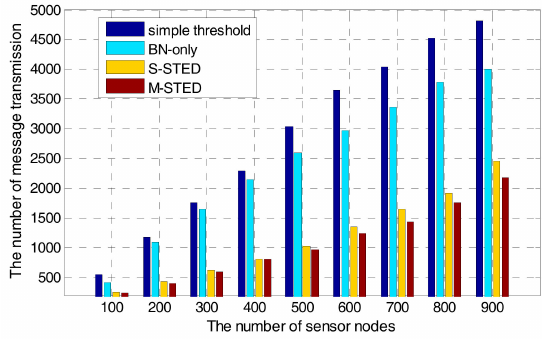
Figure 13. Scalability with an increased number of